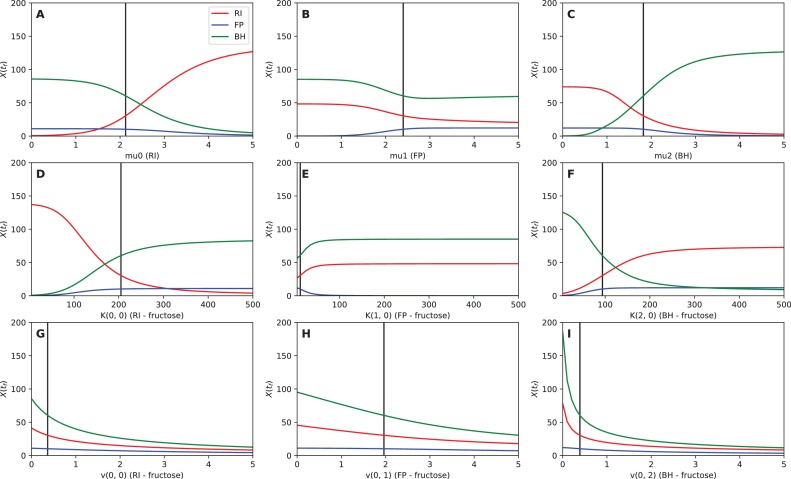
Sensitivity analysis.The abundance of Roseburia intestinalis L1-82 (RI), Faecalibacterium prausnitzii A2-165 (FP) and Blautia hydrogenotrophica S5a33 (BH) at the final time point is plotted, depending on the values of the maximal specific growth rate μ (A–C), the fructose half-saturation constant K (D–F) and the fructose uptake rate v (G–I).